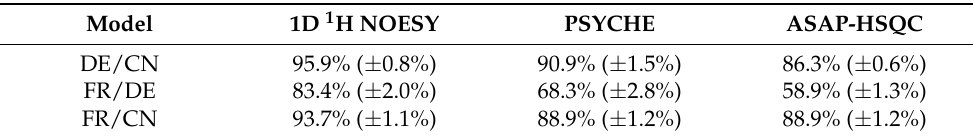
Table 1. Accuracies of the classification of all three two-class models (DE/CN, FR/DE, FR/CN) based on the different NMR experiments ( 1 H NOESY, PSYCHE, ASAP-HSQC). CN: China; DE: Germany; FR: France.